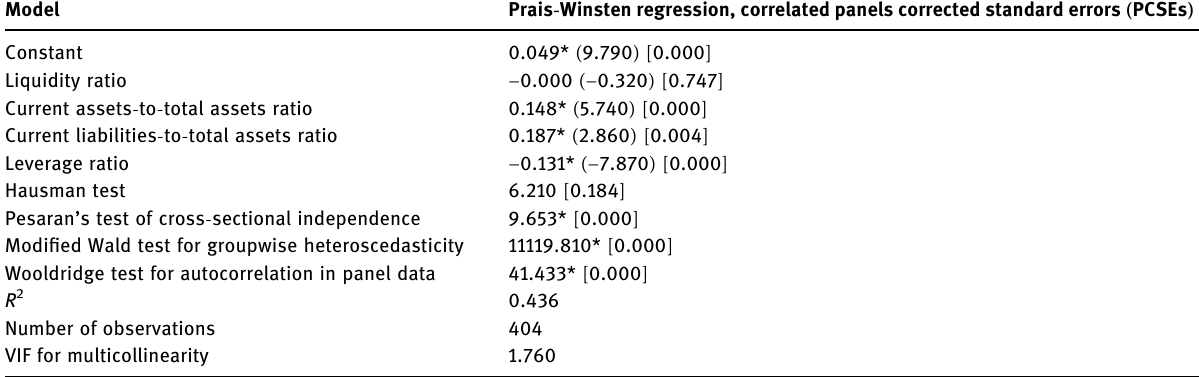
Table 7: Regression results for pro fi tability as dependent variables with panel data across the 28 former European Union countries and over the period 2004 – 2018 Model Prais - Winsten regression, correlated panels corrected standard errors ( PCSEs )